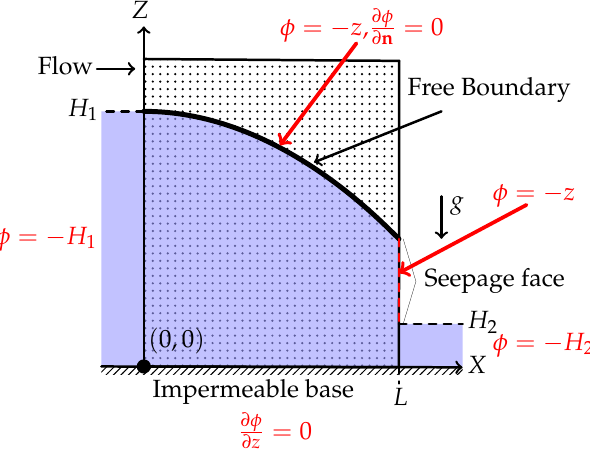
Figure A1. Schematic diagram of the test problem where H 1 = 1 and H 2 = 1